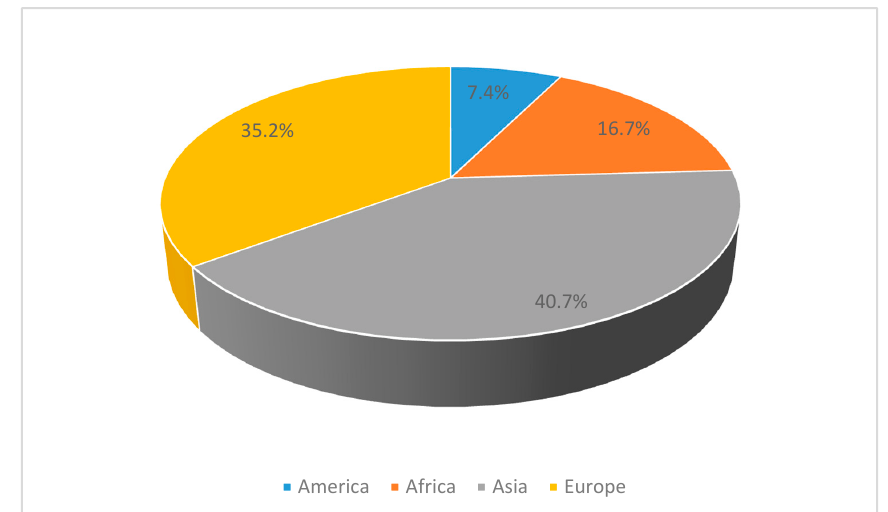
Figure 3. Continental distribution of subjects. Int. J. Environ. Res. Public Health 2019 , 16 , x FOR PEER REVIEW Table 4. Geographical regions of origin for LMIC(low- and middle-income countries) subjects.